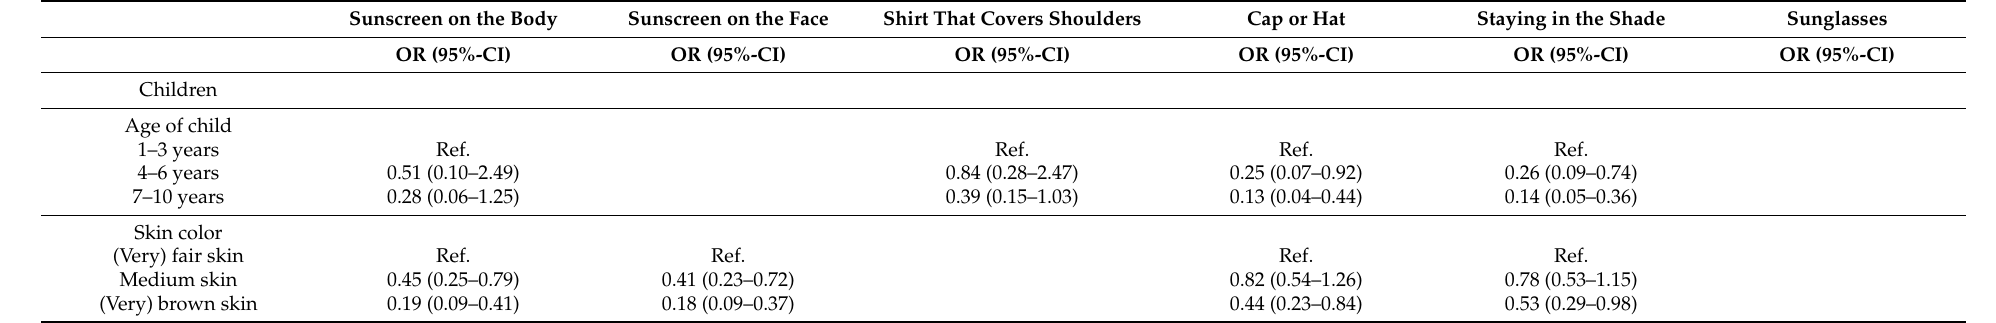
Table 3. Logistic regression analyses on sun protection measures based on answers of 554 participants in wave 2020 of the National Cancer Aid Monitoring